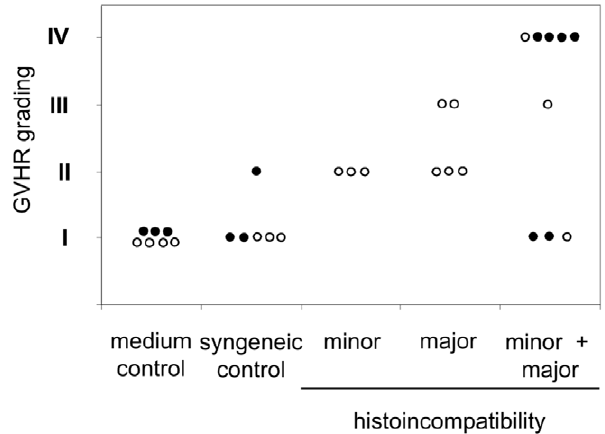
Figure 5. Induction of a GVHR in a second series of BN (filled circles) and LEW.1N (open circles) rat skin explants. Skin explants were co-cultured with pre-stimulated allogeneic lymphocytes from rats with a minor (BN lymphocytes and LEW.1N skin), major (LEW.1A ( RT1 a ) or LEW.1AV1 ( RT1 av1 ) lymphocytes and LEW.1N skin), or a minor and major histoincompatibility (PVG lymphocytes ( RT1 c ) and BN skin or LOU/C ( RT1 u ) lymphocytes and LEW.1N skin). A summary of the histological GVHR grading of skin samples cultured in medium alone, together with syngeneic BN or LEW.1N lymphocytes, and together with allogeneic lymphocytes is